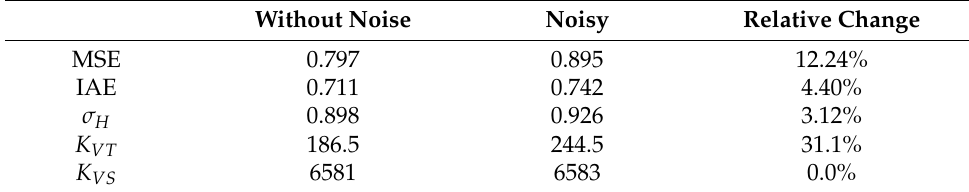
Table 10. G 1 ( s ) CPA indexes.